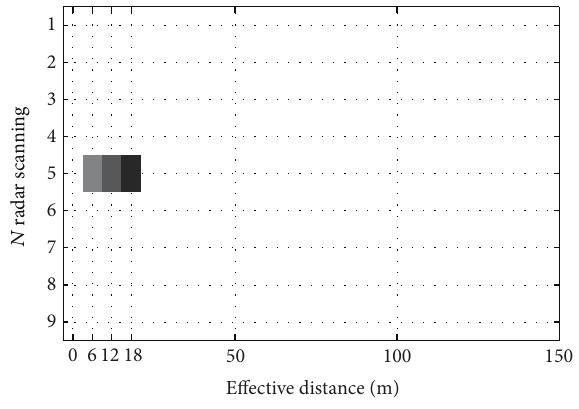
Figure 9: SDRadar map for a single scanning.